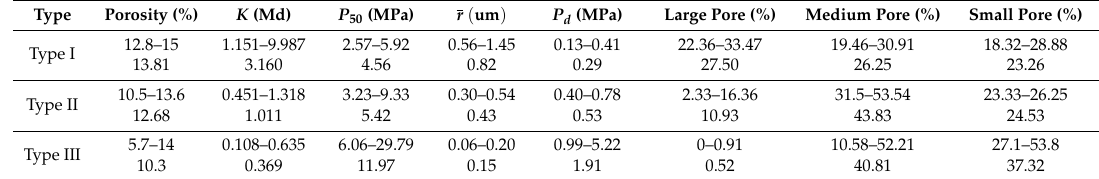
Figure 4. The mercury injection capillary pressure (MICP) curves of different types of reservoirs: ( a ) the pore throat size distributions of different types; ( b ) the mercury capillary pressure curves of different types. Table 3. Classification of reservoirs according to physical properties and MICP parameters.